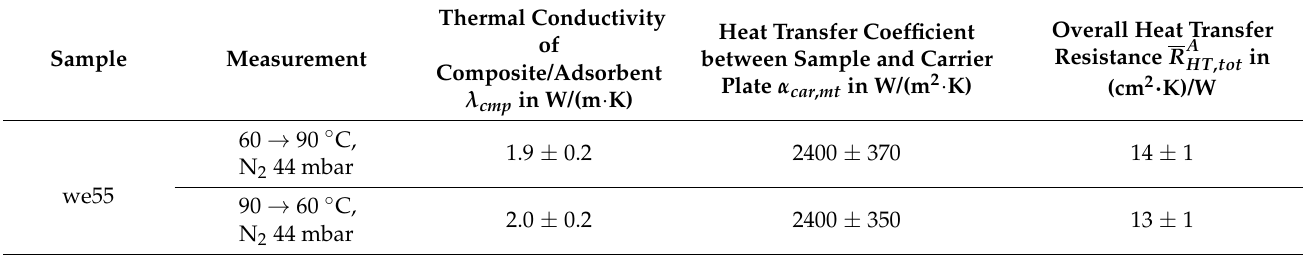
Table 7. Heat transfer parameters determined with inert-LTJ